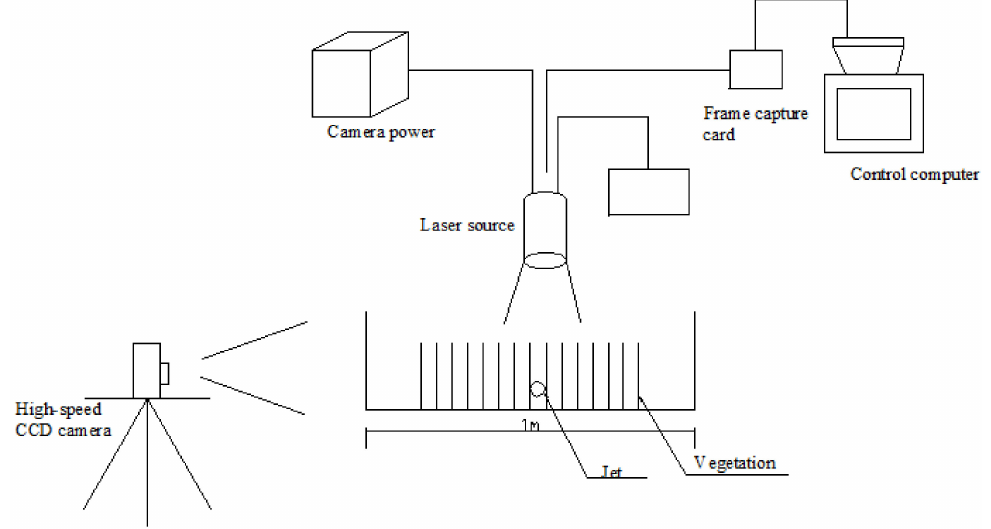
Figure 2. PIV measurement system and photo